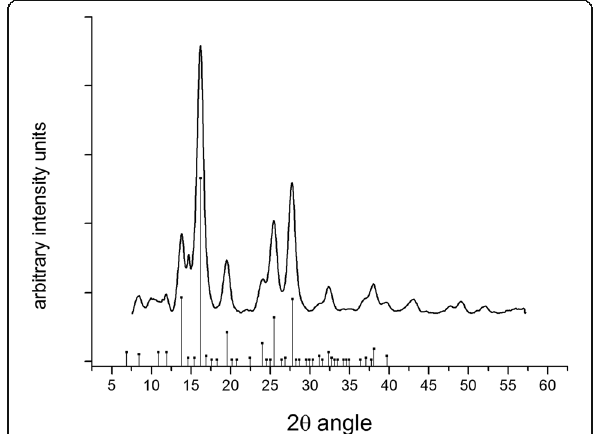
Fig. 13 A powder diffractogram of the produced maghemite nanoparticles. The peaks align with the positions of standard maghemite from the database seen as point with drop line at the base of the figure. Crystallite size was calculated from the largest peak at 16.197 2 θ degrees